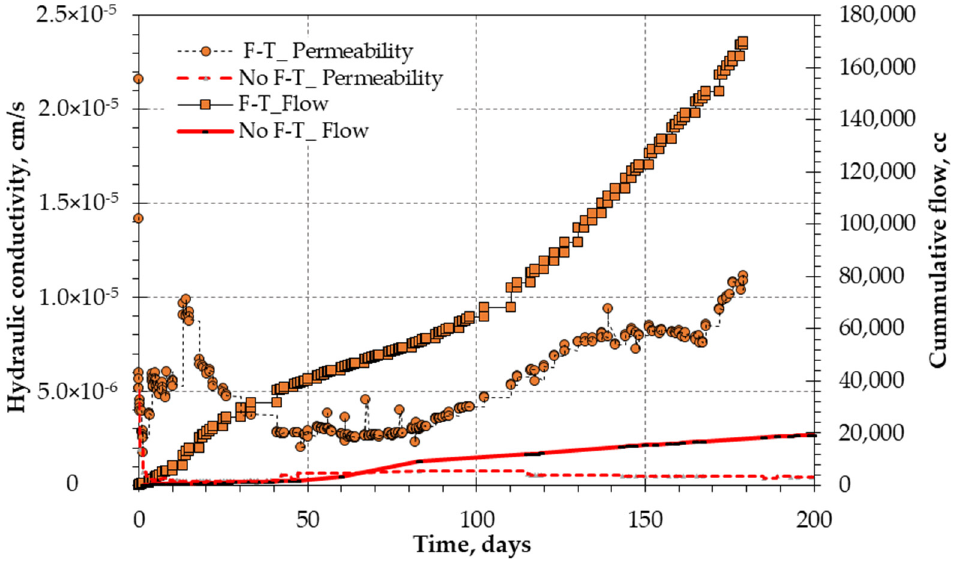
Figure 7. Hydraulic conductivity and cumulative flow for 20%Q before and after freeze–thaw cycles under 30 kPa stress.